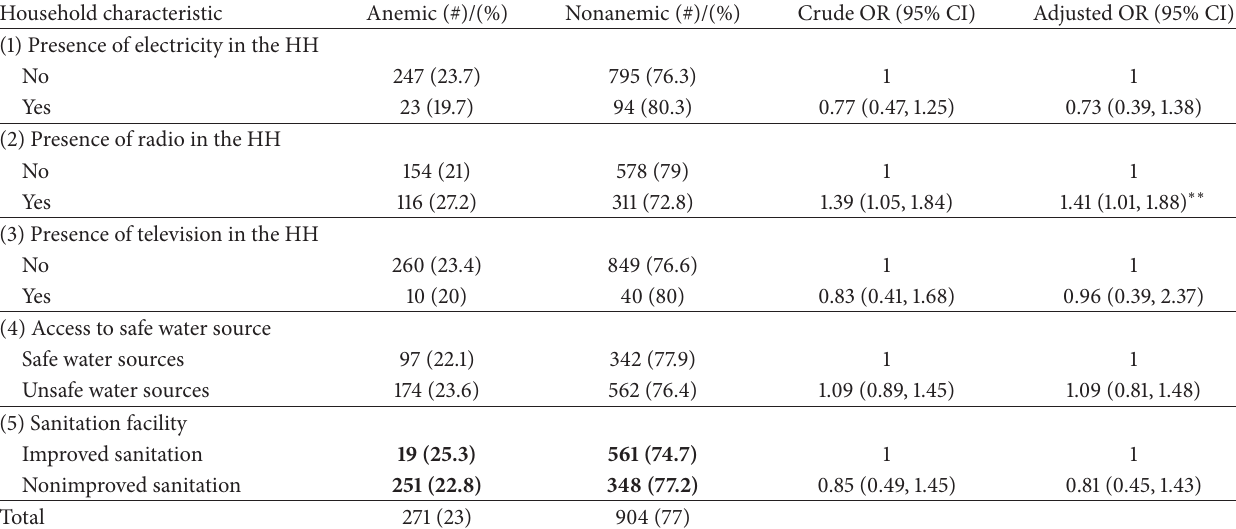
Table 2: Selected household characteristics of pregnant mothers and their association with anemia during pregnancy in Ethiopia, EDHS 2011. Household characteristic